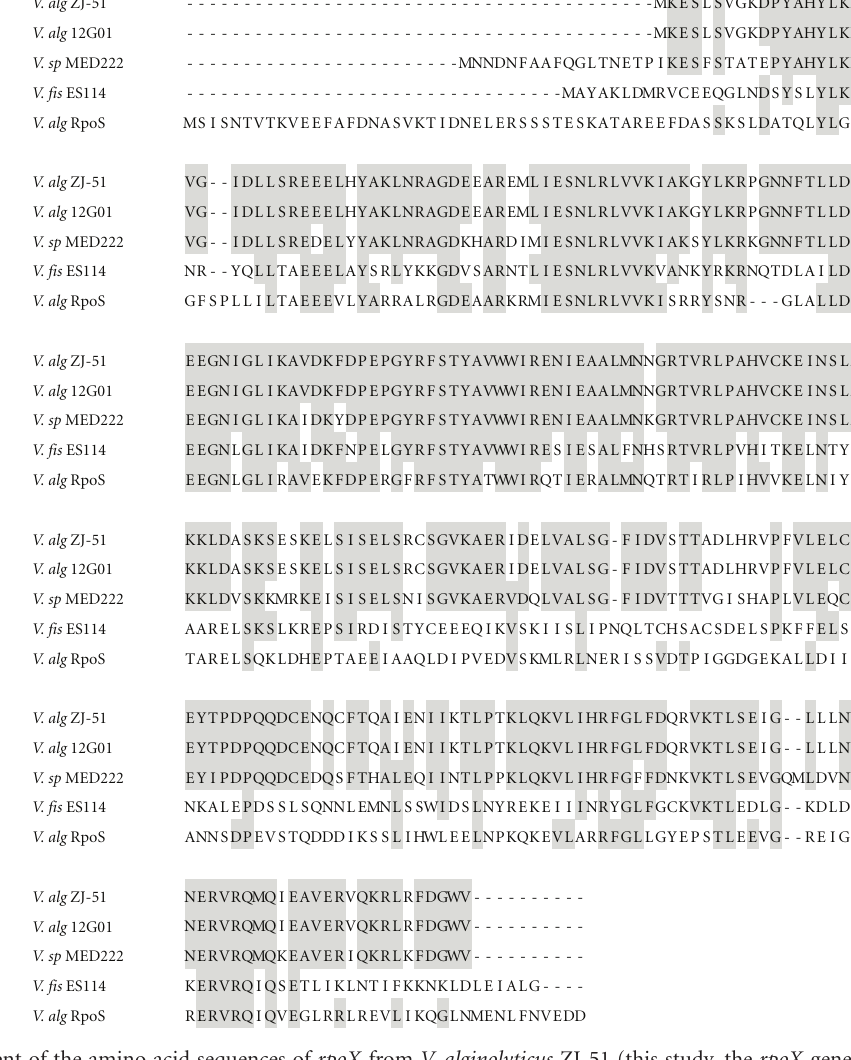
Figure 1: Alignment of the amino acid sequences of rpoX from V. alginolyticus ZJ-51 (this study, the rpoX gene gb: FJ358498), rpoS -like sigma factor from V. alginolyticus 12G01(ZP 01261551), Vibrio sp. MED222 (ZP 01063551) and V. splendidus LGP32 (YP 002395435), RpoQ from V. fischeri ES114 (YP 206973), and rpoS from V. alginolyticus (ABW86844) with the accession number of the databases indicated in parentheses. Identical amino acid residues present in three or more proteins are boxed in black. Similar residues are highlighted in gray. The V. alginolyticus rpoX translated sequence overall identity ranges from 36% to 100% for the other sequences